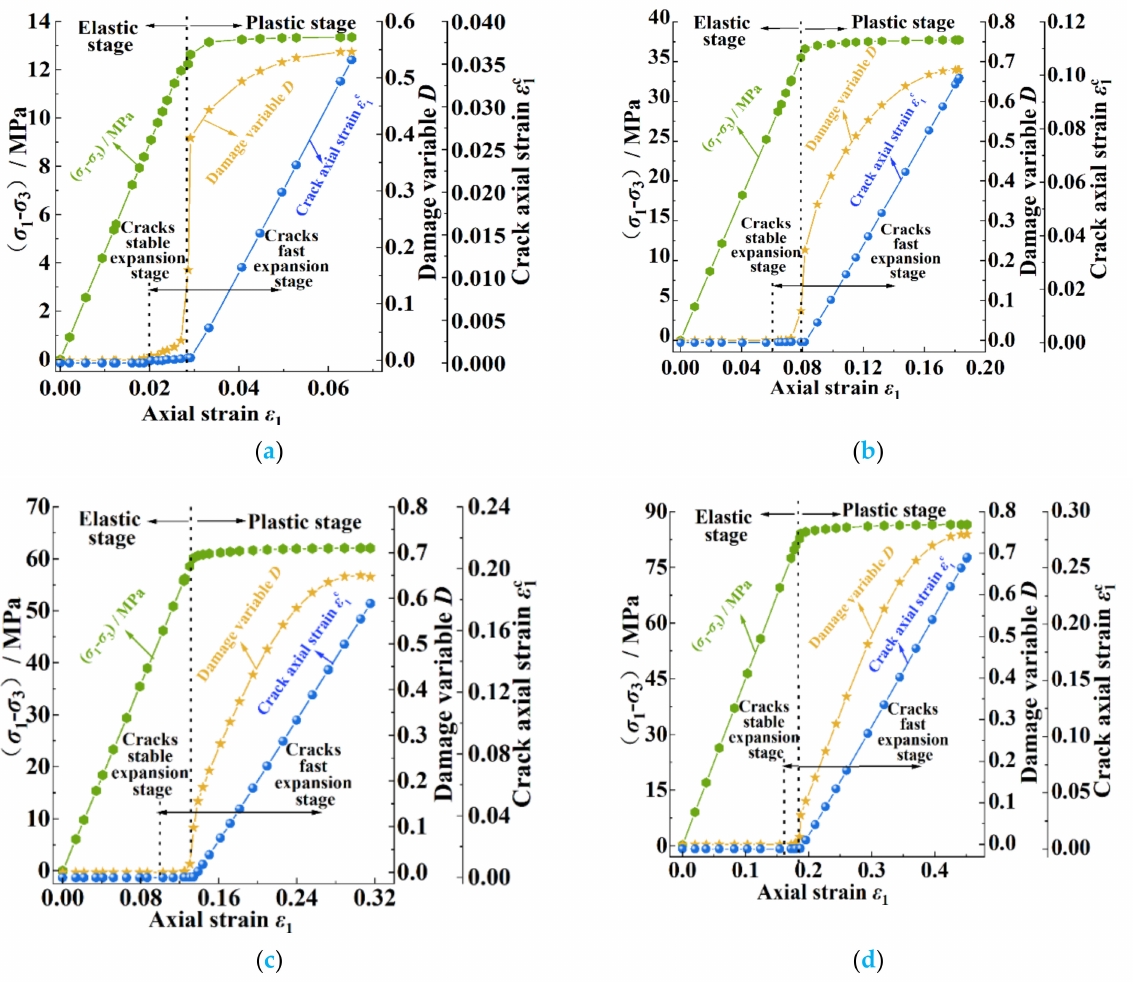
Figure 14. Cumulative curves of stress, strain, and damage under different confining pressures in pre-peak stage: ( a ) 4 MPa of confining pressure; ( b ) 12 MPa of confining pressure; ( c ) 20 MPa of confining pressure; ( d ) 28 MPa of confining